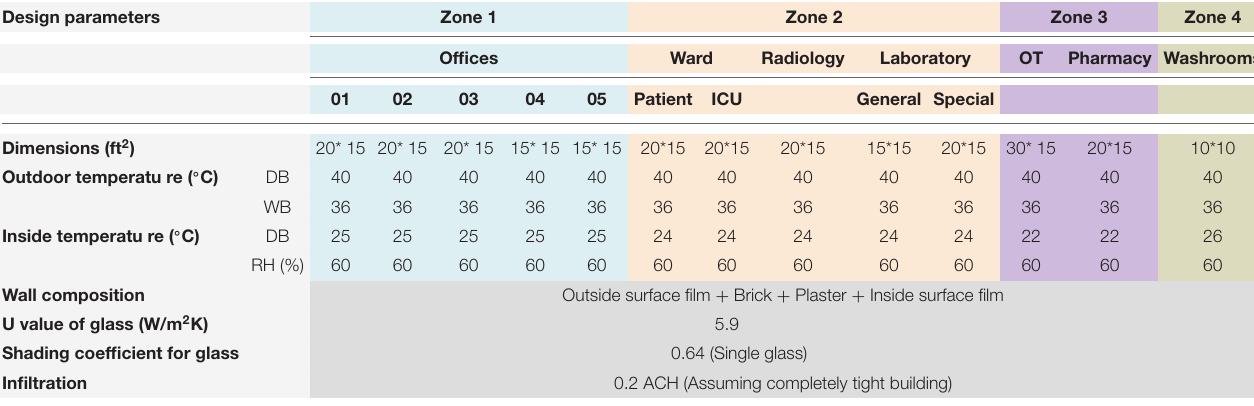
TABLE 1 | Design parameters of each zone in the hospital building.